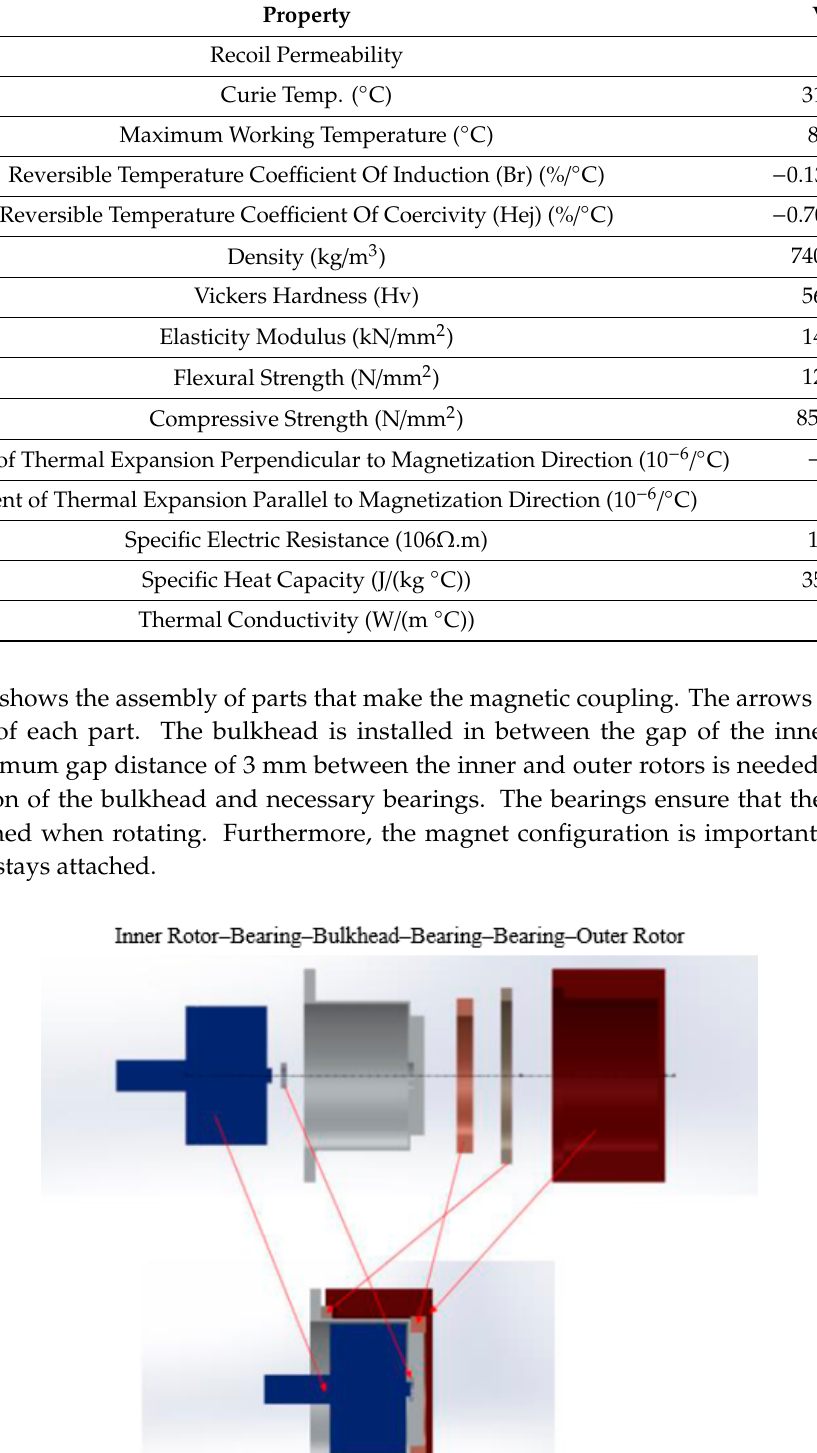
Table 1. Neodymium (NdFeB) magnet properties.